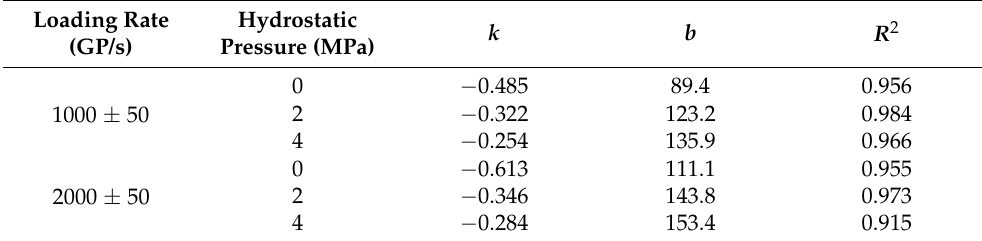
Figure 11. Dynamic compressive strength varied with freeze–thaw cycling under a certain loading rate (1000 GPa/s and 2000 GPa/s) and different hydrostatic pressures. Table 1. Fitting parameters ( k , b ) and coefficient of determination ( R 2